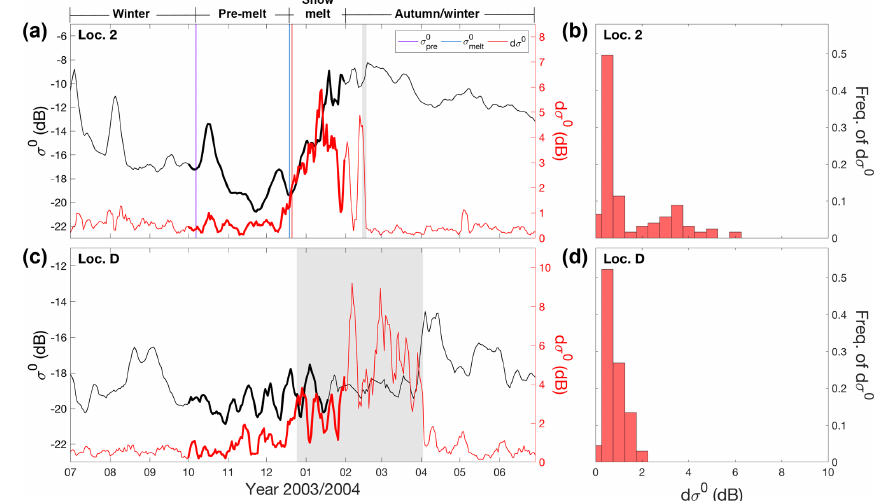
Figure 4. Typical annual time series of mean daily QSCAT radar backscatter ( σ 0 , black) and its diurnal variations (d σ 0 , red) for location 2 on perennial (a) and location D on seasonal sea ice (b) in 2003/2004. Colored vertical lines illustrate snow pre-melt ( σ 0 pre , magenta) and melt ( σ 0 , blue) onset derived from backscatter time series only and snowmelt onset derived from QSCAT diurnal backscatter variations melt (d σ 0 , red). Grey shaded areas indicate the time period with sea-ice concentration less than 70%, when the algorithm developed here cannot be applied. Bold lines denote the time period for the spring–summer transition retrieval analysis (1 October to 31 January). Histograms in (c) and (d) show frequency of occurrence of the magnitude of diurnal backscatter variations d σ 0